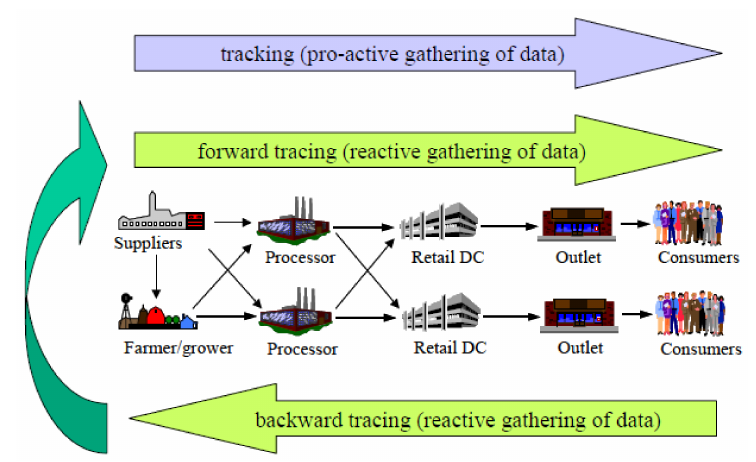
Figure 1. Tracking and tracing